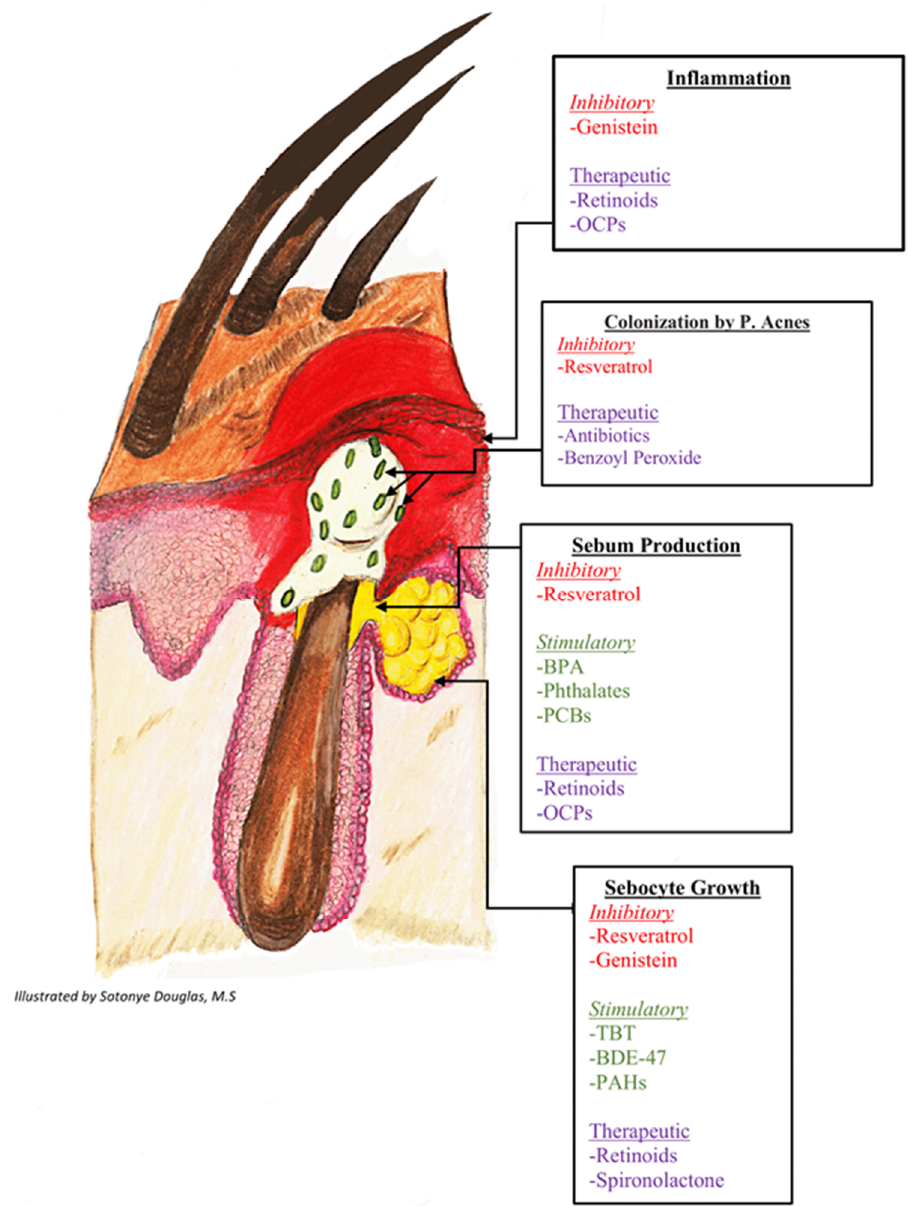
Figure 1. Stimulatory and inhibitory effects of endocrine disrupting chemicals on pathways of acne pathogenesis. 1 Genistein’s inhibitory effects are mediated by restoration of TGF-B expression and inhibition of inflammatory cytokine production. Resveratrol’s inhibitory effects are driven by downregulation of PPARy expression and inhibition of lipogenesis. 2 BPA’s stimulatory effects